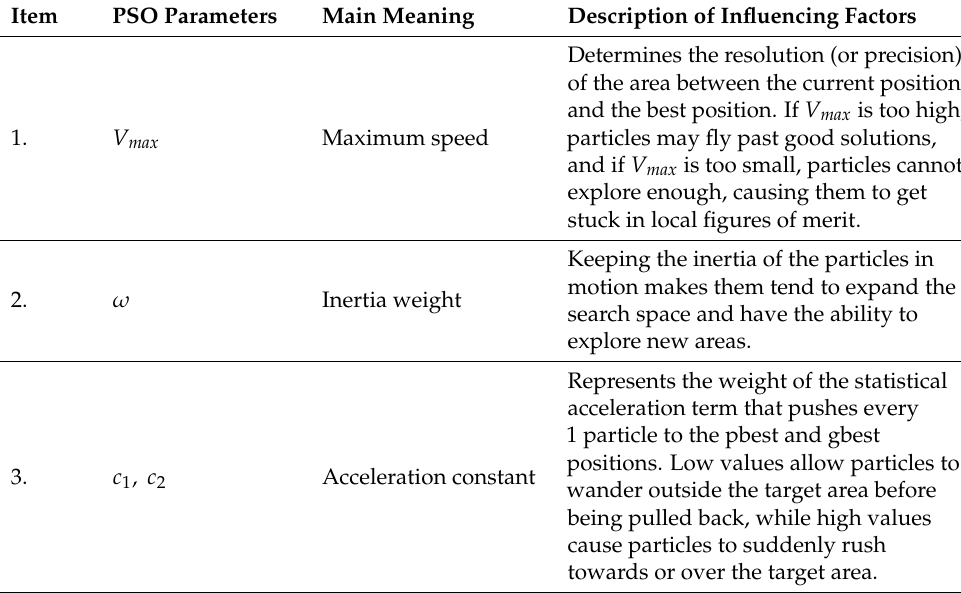
Table A1. Factors Affecting the PSO